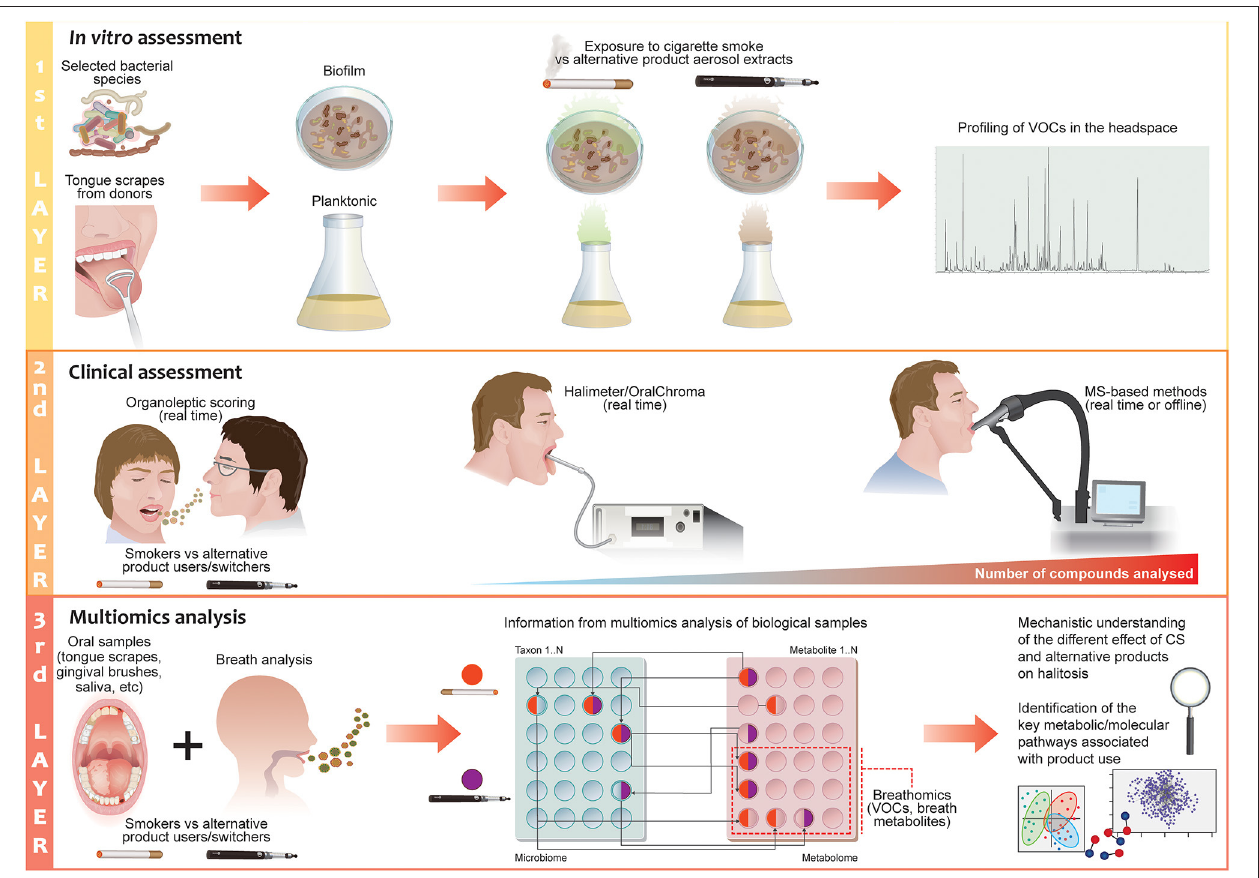
FIGURE 3 | The 3-layer halitosis analysis framework for cigarette smoking and alternative nicotine-delivery product use. The first layer of the proposed framework focuses on testing the effects of the aerosols or liquid fractions of alternative nicotine-delivery products in comparison to cigarette smoke/extract in vitro . Selected bacterial species with known effects on halitosis or tongue scrapes from halitosis patients/donors can be employed in planktonic or biofilm models; the headspace of the flasks or plates is analyzed to detect volatile organic compounds by using MS-based instruments. The second layer focuses on validating the results from the in vitro / ex vivo experiments with clinical measurements of the breath of cigarette smokers and users who have switched to alternative nicotine-delivery products. Real-time breath measurements can be performed with MS-based techniques in a laboratory setting to discover new potential biomarkers of halitosis and provide quantitative measurement of a halitosis-related compound. Evaluation by organoleptic judges is incorporated in the design of the clinical study to define the degree of odor in the subjects. The third layer of the investigation focuses on gaining a mechanistic understanding of the causes of halitosis in relation to CS or alternative nicotine-delivery product use by applying a multiomics approach that encompassed microbiomics and